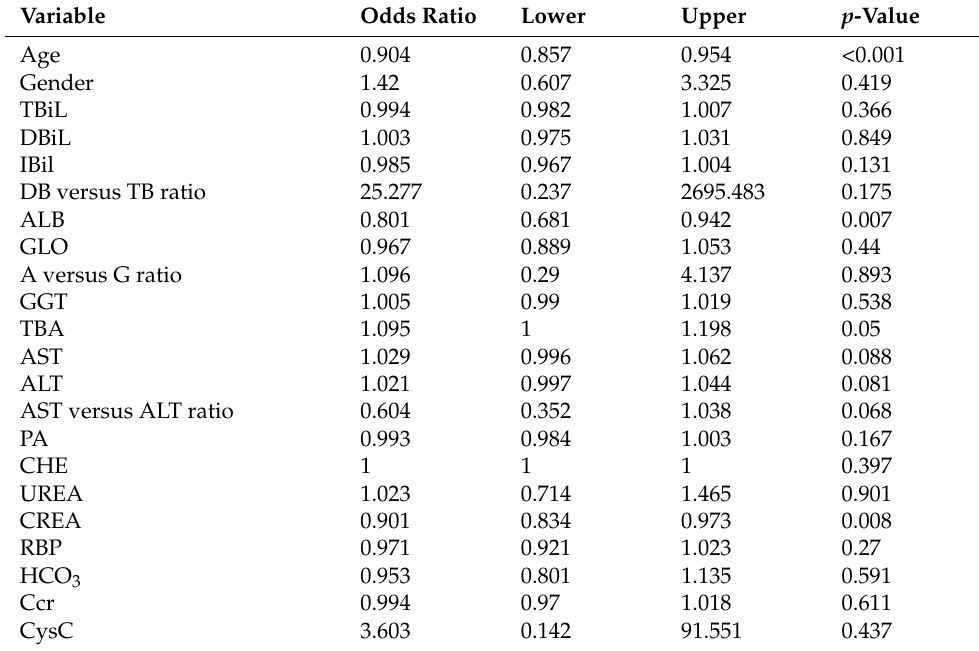
Table 2. Univariate logistic regression analysis of the clinical